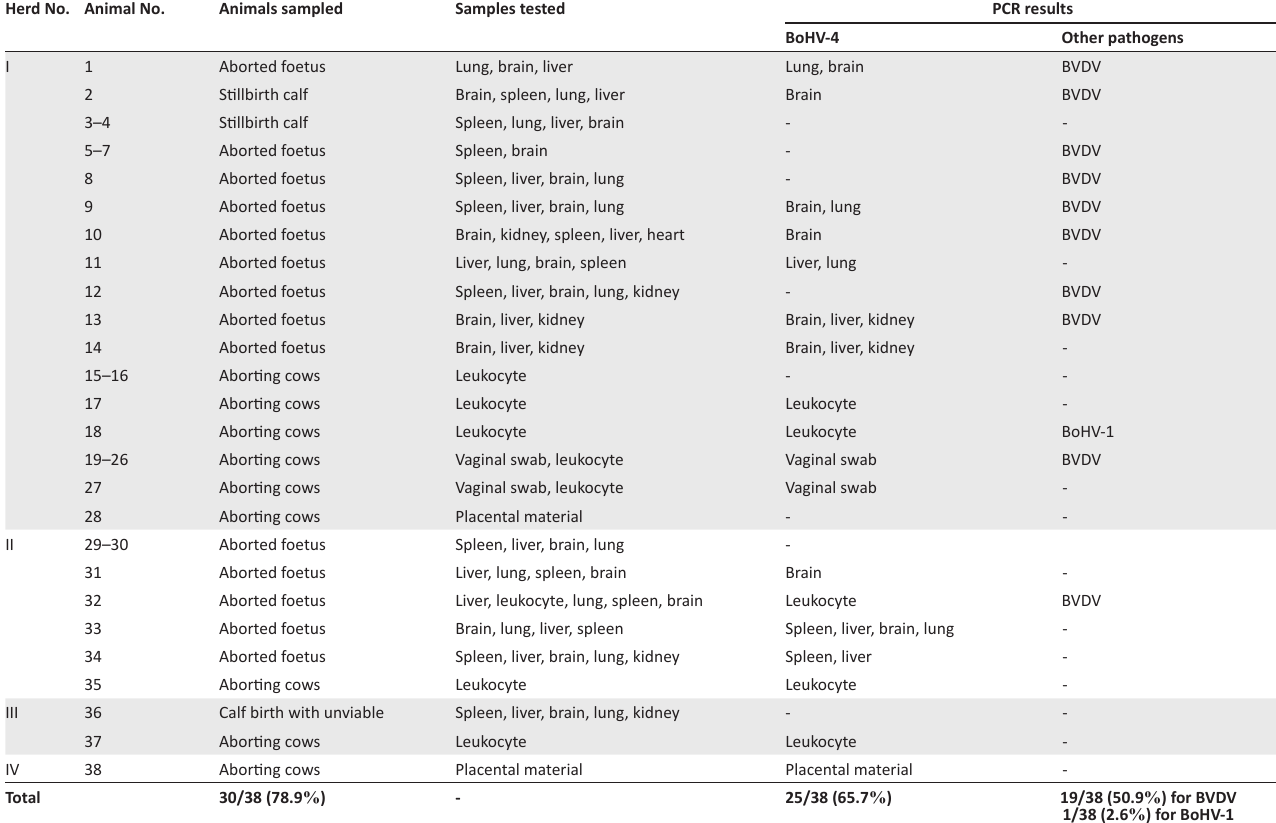
TABLE 1: Distribution of materials and animals tested and polymerase chain reaction results. Herd No. Animal No. Animals